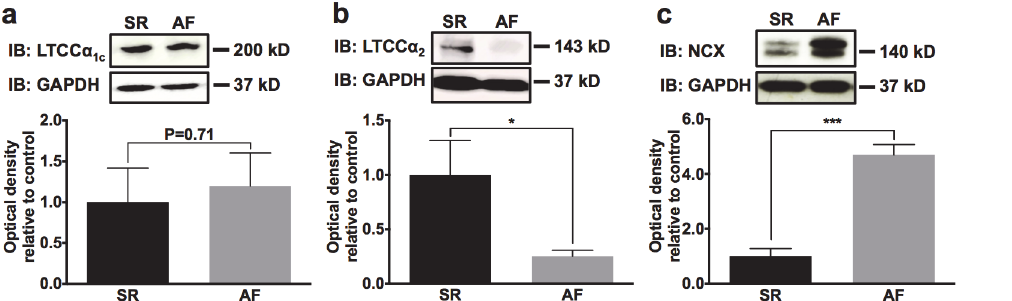
phosphorylation at Ser2814 (n = 5; P = 0.82) was not different between AF and SR animal groups (Fig. 5A-D).